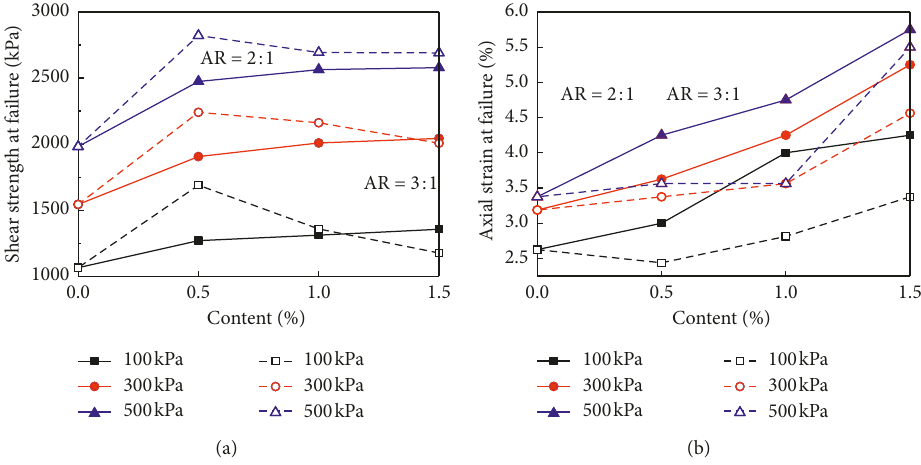
Figure 3: Variations in (a) shear strength and (b) peak strain under the effects of fabric block content and aspect ratio.